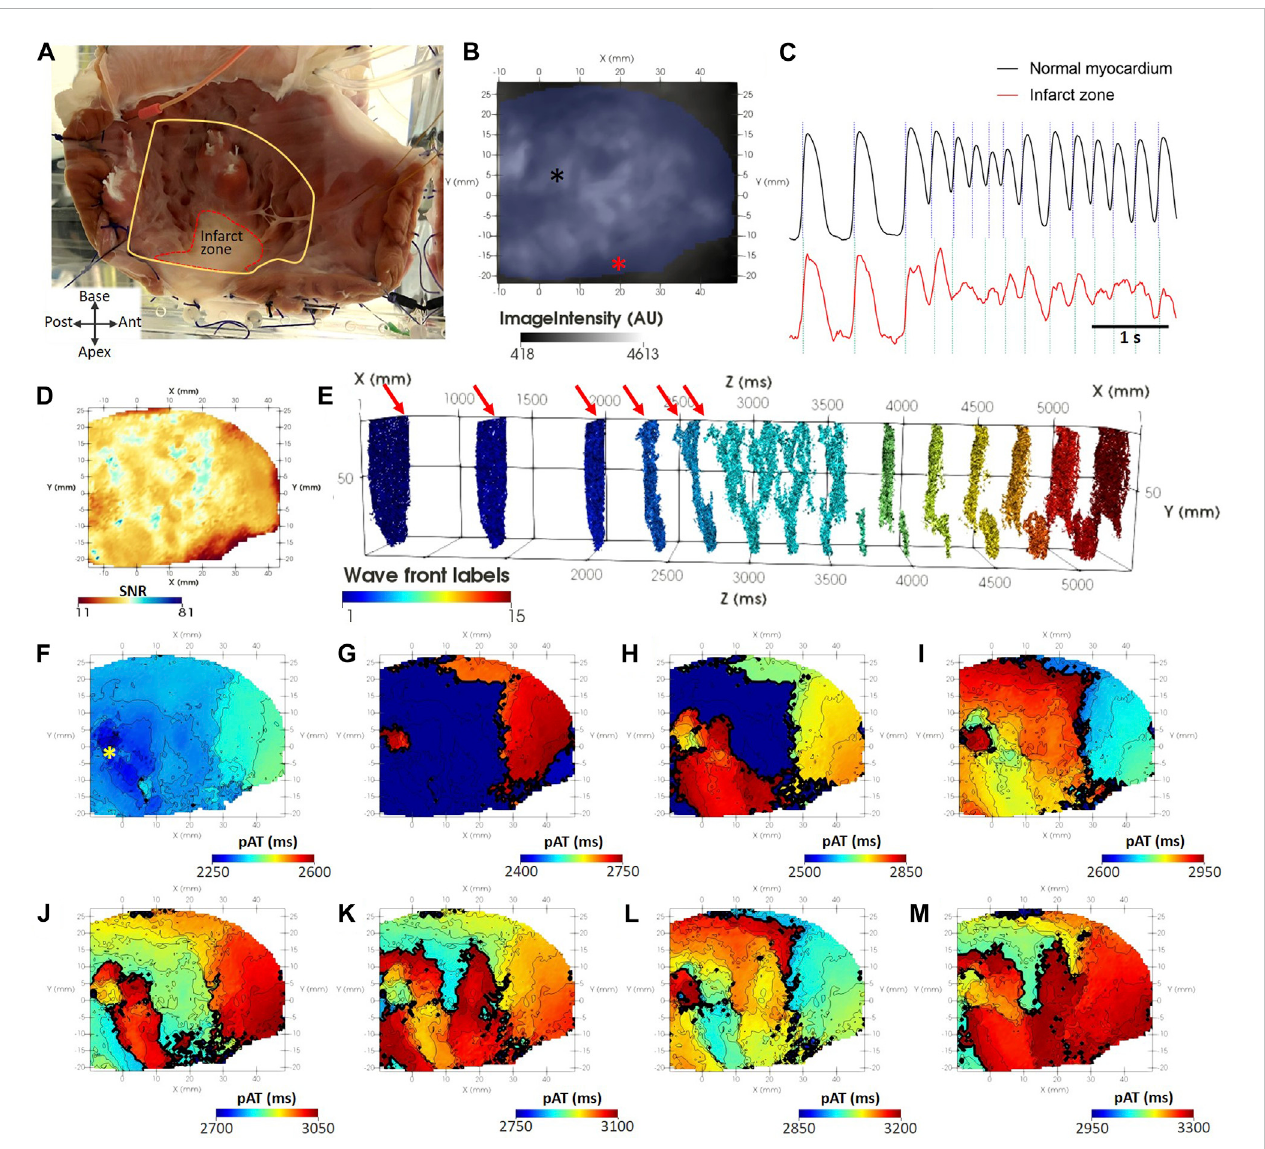
FIGURE 10 pAT mapping tachyarrhythmia in chronic myocardial infarction. (A) The endocardial surface was subject to optical mapping, encompassing a region of scar in the ventricular apex. (B) Backgroundoptical mapping signals. (C) Optical mapping traces taken from normal myocardium [black asterisk in (B) ] and the scar region [red asterisk in (B) ]. (D) Map of SNR from the same optical mapping recording. (E) pAT matrix with labelled wave fronts and indicating the timing stimulation pulses (red arrows). (F – M) Progressive pAT maps during the onset of